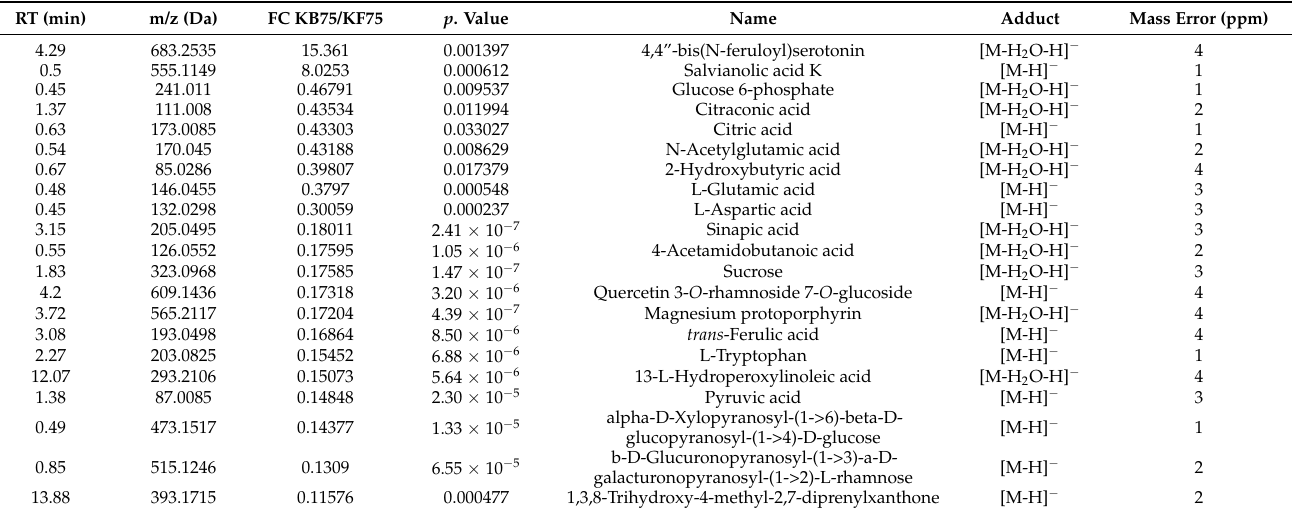
Table 5. Tentative identification of chemical markers in ESI-mode in the evaluation of the biofertilizing effect of Acinetobacter calcoaceticus UTMR2 in tomatillo fruits ( Physalis ixocarpa Brot. cv. “c á scara morada”) at 75% of the recommended potassium dose